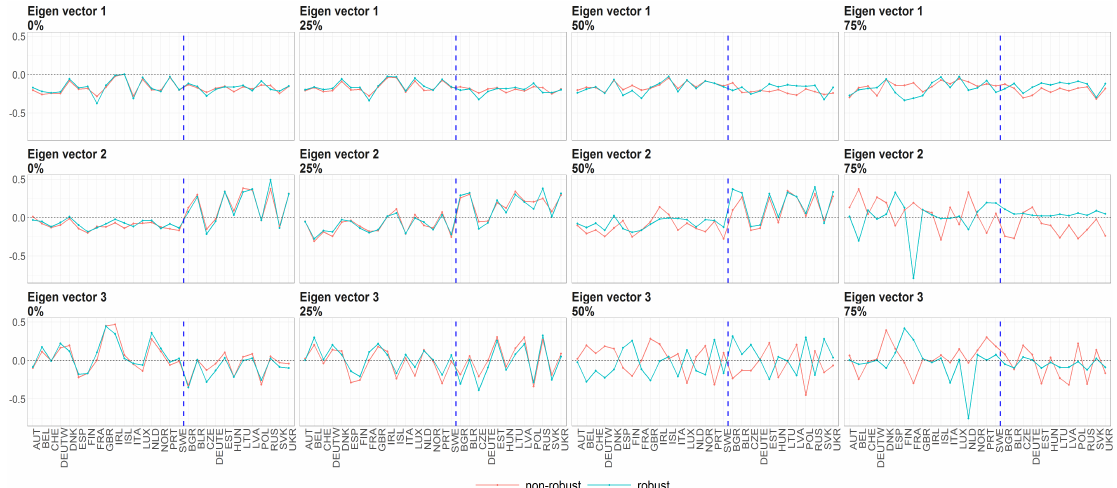
Figure 14. The eigenvectors (y axis) over the joint distribution of countries (x axis) obtained using PPCA for male population of Life Expectancy at Birth. Every row of subfigure corresponds to different eigenvector. Every column corresponds to different level of maximum missing values per observation (0%, 25%, 50% and 75%). The blue line corresponds to robust standardisation whereas red line to non-robust standardisation of